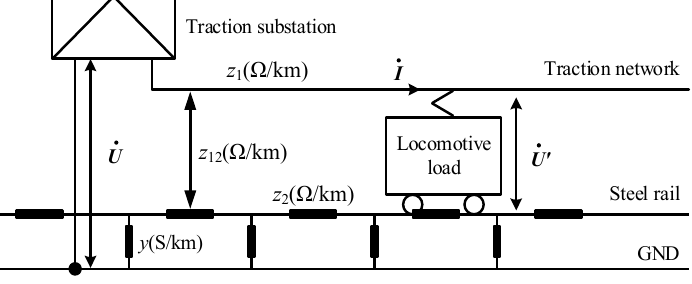
Figure 4. The control strategy and modulation strategy of single-phase 3L-NPC cascaded inverter.